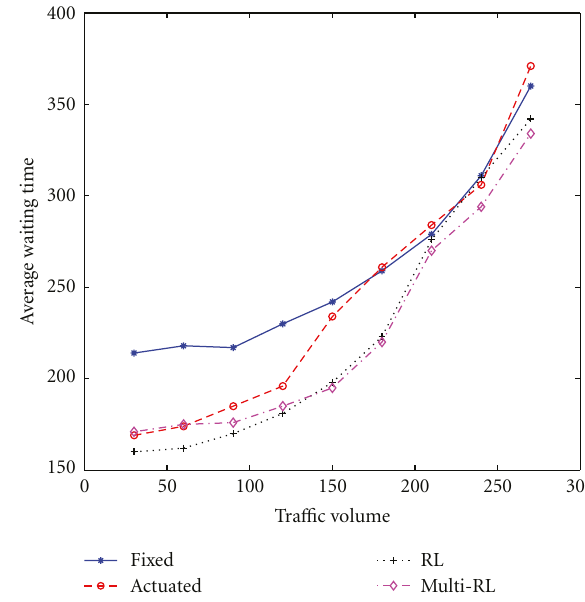
Figure 4: Control e ff ects comparison estimated by average stops. the only one that aims to minimize the number of stops.